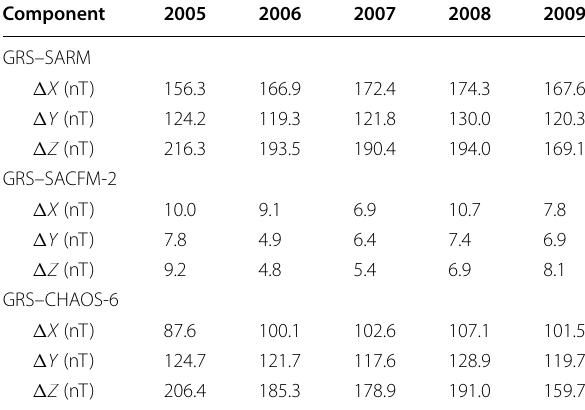
Table 8 The RMS values of the differences between geo- magnetic repeat stations input data (GRS) and the three models, SARM, SACFM-2 and CHAOS-6 for the